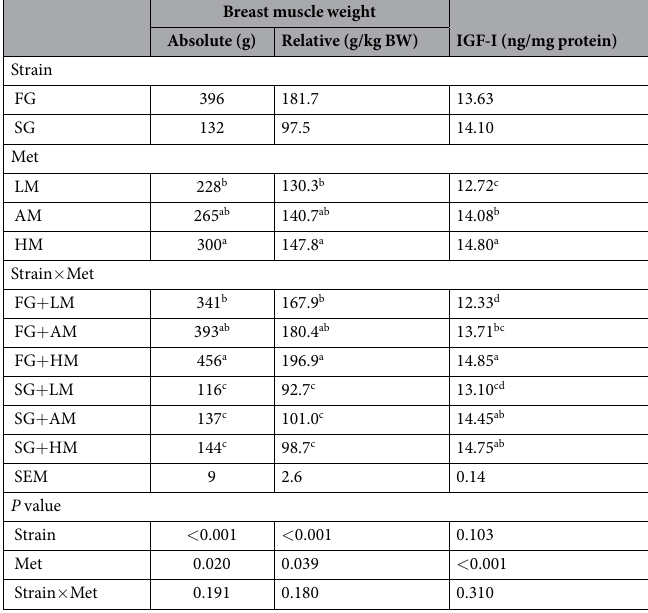
Table 2. Effects of dietary methionine on breast muscle weight and insulin-like growth factor-I (IGF-I) concentration of broilers at 42 d of age. Results are presented as means and pooled SEM (n = 6). Mean values within a column with unlike superscript letters were significantly different ( P < 0.05).